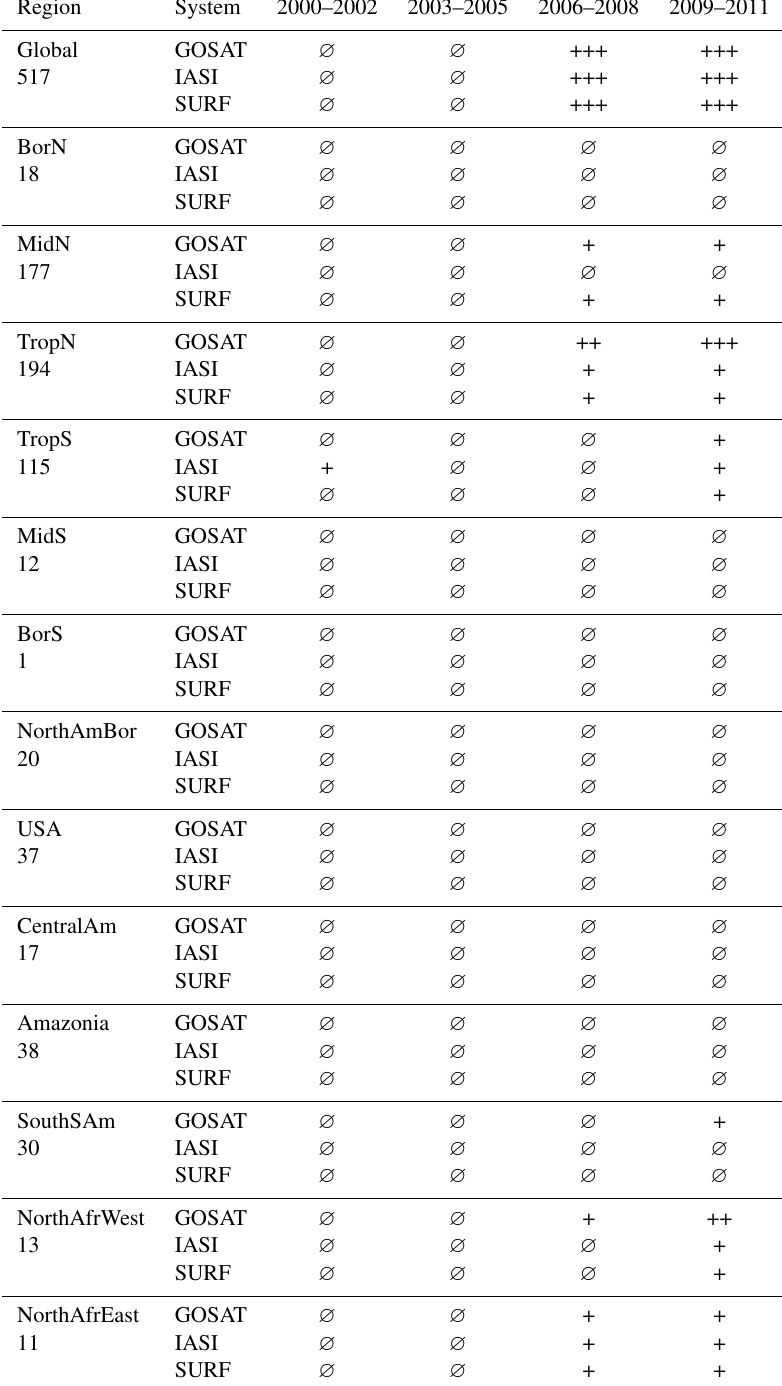
Table 3. Detection of the signal consisting in the anomalies at the 3-yearly timescale. The signal is the difference between each 3-year time is computed at the 3-yearly timescale from each of the three observation systems, GOSAT, IASI and SURF. See Sects. 2.4 and 2.3 for details. In each cell of the table, we show whether a positive anomaly, a negative anomaly or no anomaly is detected and with which signal-to-noise ratio: positive anomaly detected: +++ = stn ratio > 3, ++ = stn ratio > 2 and + = stn ratio > 1; negative anomaly detected with −−= stn ratio < − 2, −= stn ratio < − 2, ∅ , = no anomaly detected. The number below the name of the area is the average emitted mass of CH 4 over 2004–2005 in the